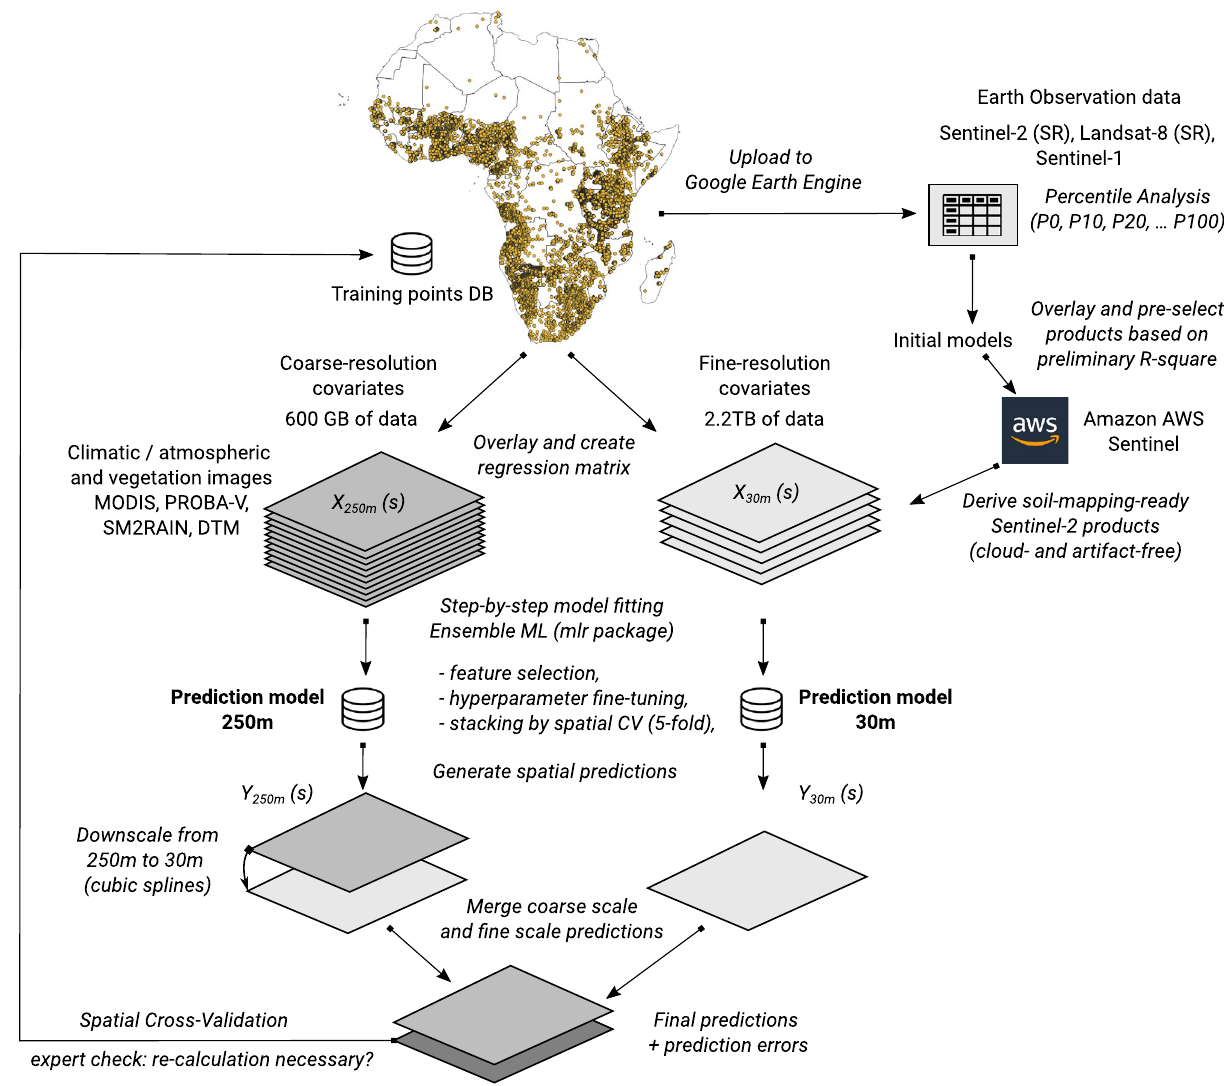
Figure 7. Scheme: a two-scale framework for Predictive Soil Mapping based on Ensemble Machine Learning (as implemented in the mlr and mlr3 frameworks for Machine Learning 28 and based on the SuperLearner algorithm). This process is applied for a bulk of soil samples, the individual models per soil variable are then fitted using automated fine-tuning, feature selection and stacking. The map is showing distribution of training points used in this work. Part of the training points that are publicly available are available for use from https :// gitla b.com/openl andma p/compi led-ess-point